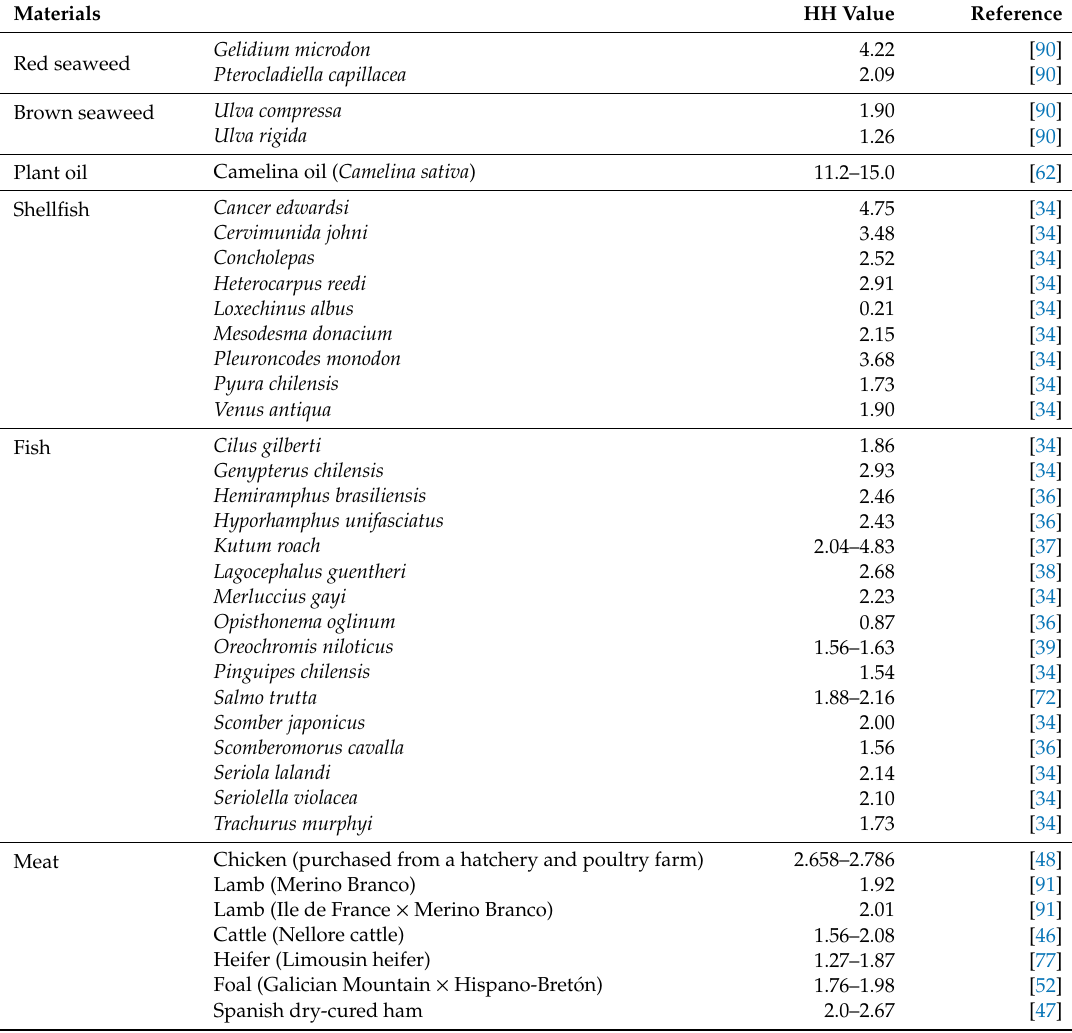
Table 5. Application of HH in fatty acid evaluation